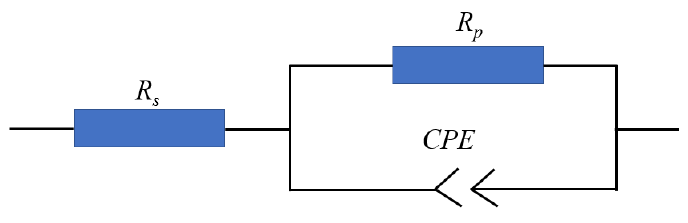
Figure 5. Nyquist ( a ) and Bode ( b ) plots of forged and SLMed Ti-6Al-4V alloys in 0.1 mol/L NaOH solution.